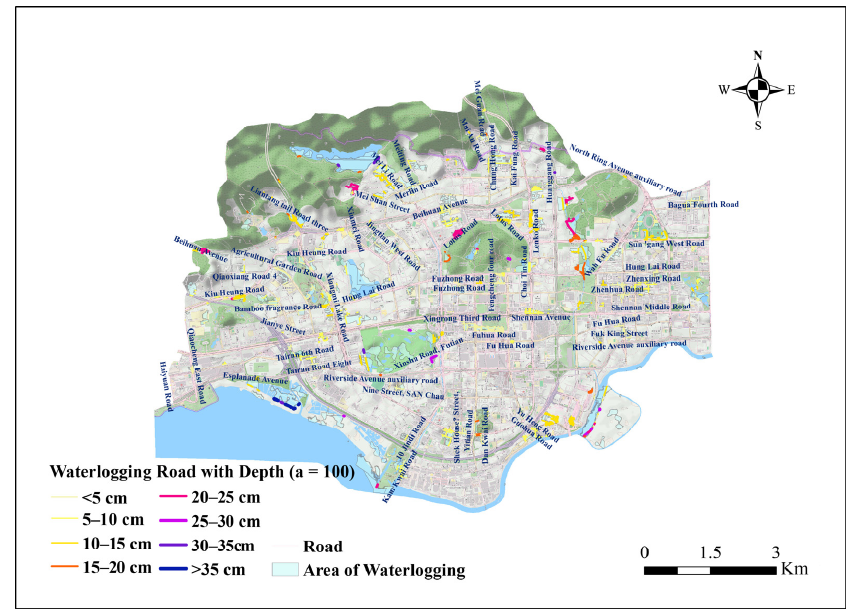
Figure 14. Waterlogging roads with different depth in a = 100 rainstorm scenario.